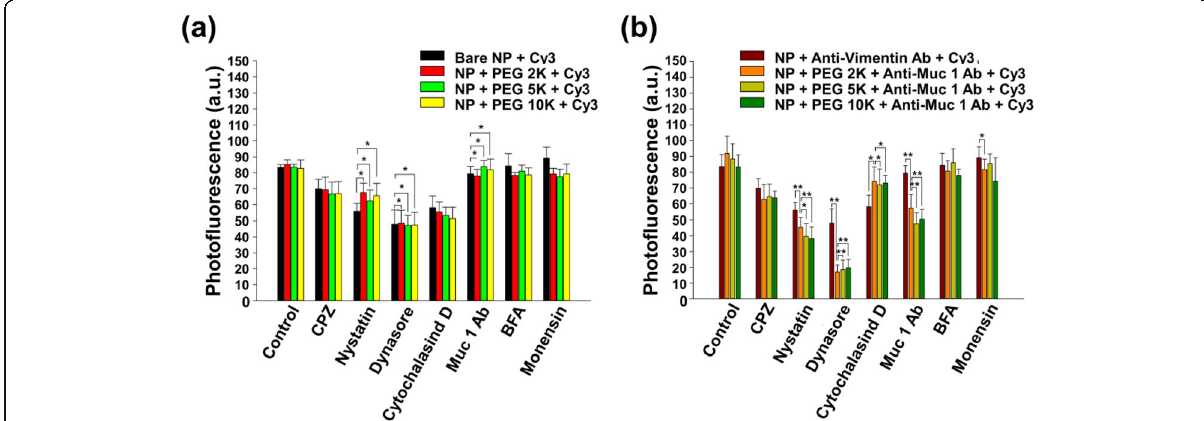
Fig. 5 Normalized photofluorescence from CT26 mucin cells treated with chemical endocytosis inhibitors for 1 h and incubated with 50 μ g/mL a bare core-shell NPs and b nanobody-tagged NPs at 37 °C in 5% CO 2 for 30 min. Inhibitors with a statistical effect on the internalization (Student ’ s t test, p (*) < 0.05 and p (**) < 0.01) are marked with black